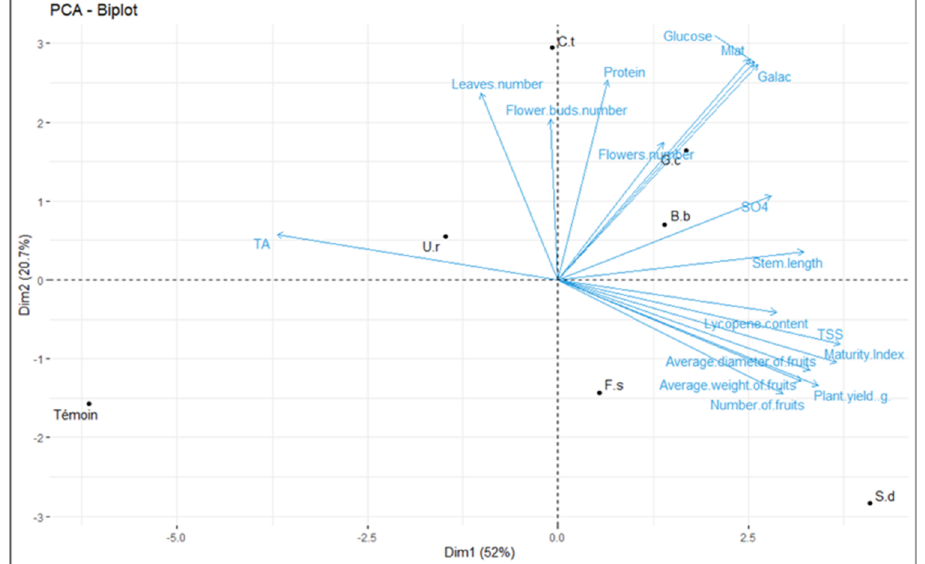
Figure 3. Principal component analysis between the following variables: glucose, maltose, galactose, protein, and sulfate SO4 content, plant growth parameters (leaves number, stem length, flowers numbers, and flower buds numbers), plant yield parameters (plant yield, average weight and diameter of fruits, and number of fruits) and fruit quality parameters (total Sec-soluble TSS, maturity index, and lycopene